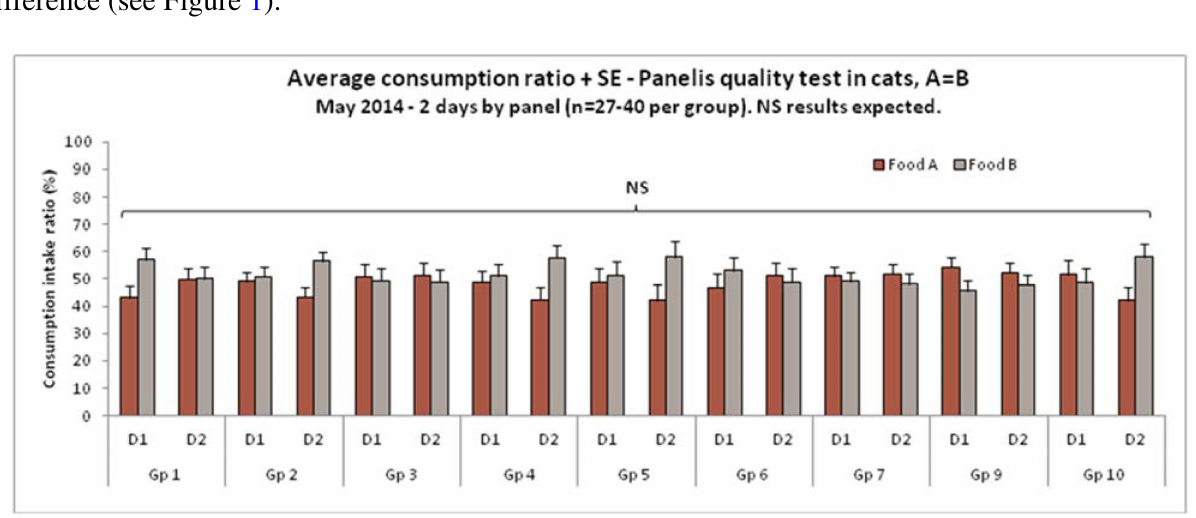
Figure 1. Average consumption ratio and Panelis quality test in cats, A = B, May 2014, 2 days by panel ( n = 27–40 per group). None significant (NS) results